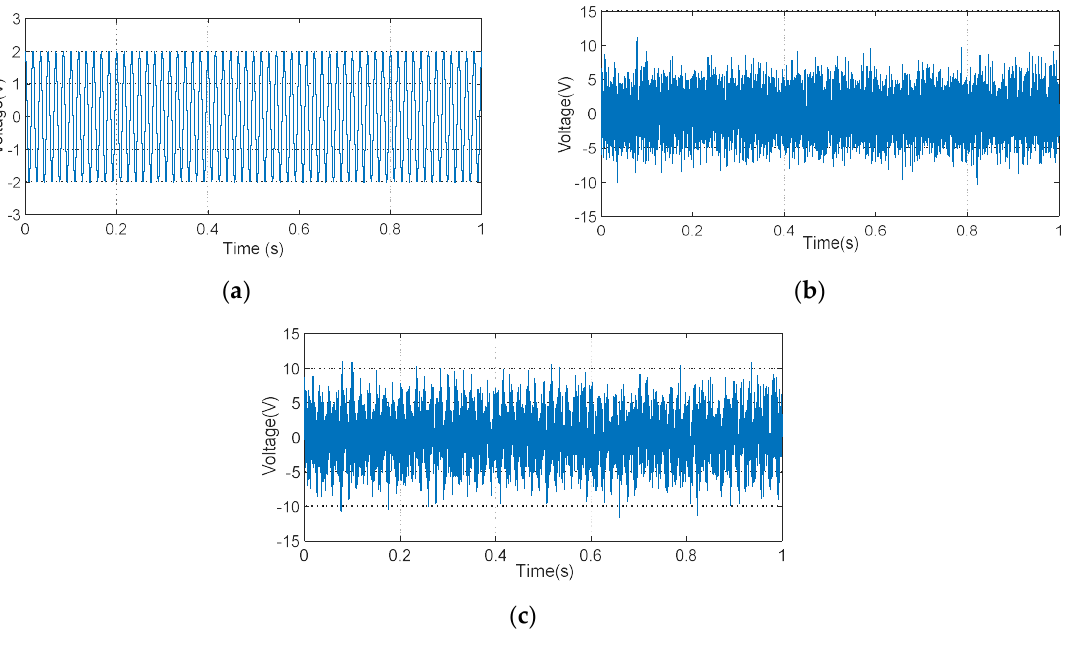
Figure 13. Input signal waveform. ( a ) 60Hz oscillatory signal; ( b ) White Gaussian noise; ( c ) Superimposed input signal.